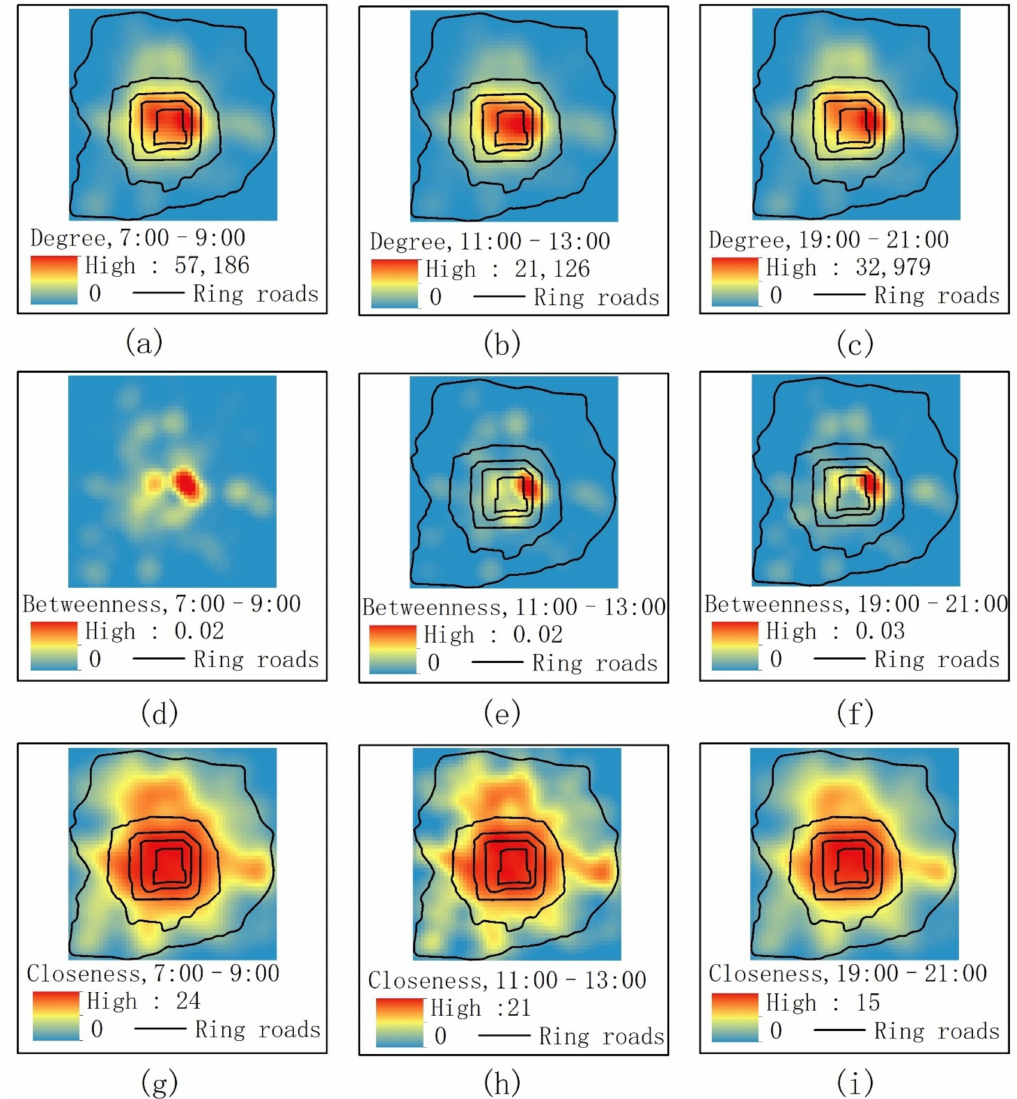
Figure 6. Spatial distributions of weighted degree centrality indices on weekdays: ( a ) degree, 7:00–9:00; ( b ) degree, 11:00–13:00; ( c ) degree, 19:00–21:00; ( d ) betweenness, 7:00–9:00; ( e ) betweenness, 11:00–13:00; ( f ) betweenness,